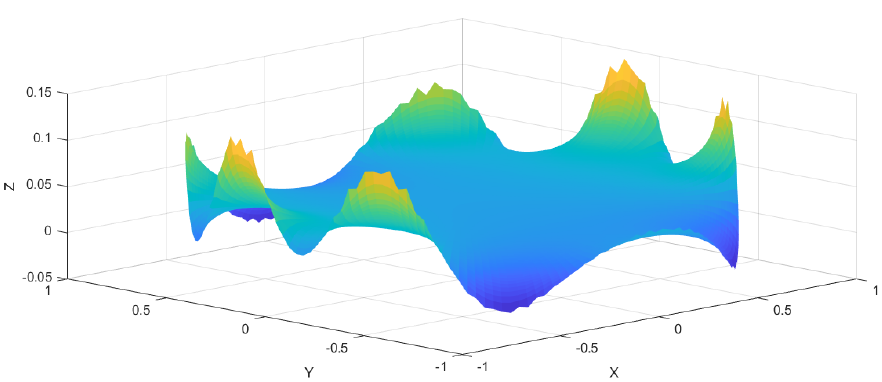
Figure 3. Boundary condition and numerical solution ˜ u h of (21) for α = 0.65 and N = 512 inside the domain.